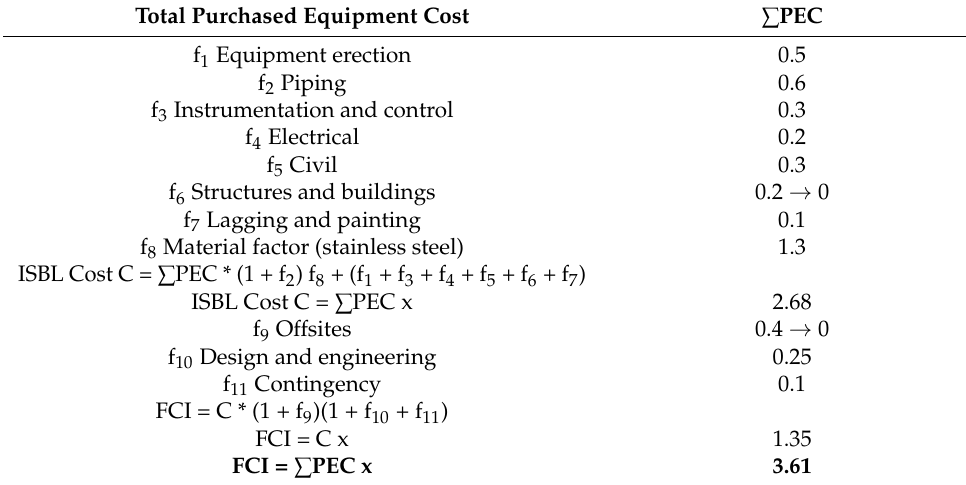
Table 2. Factors used in the detailed factorial method for estimating the fixed capital investment